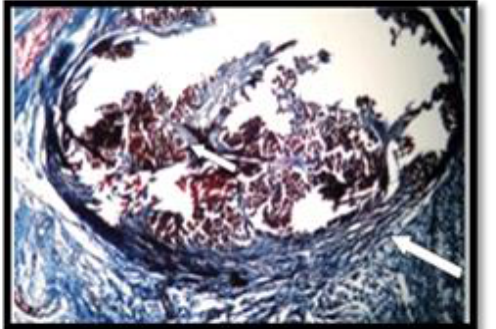
Figure, 9: BP-treatment group at 16th week post implantation, shows BP implant and surrounded (encapsulate) by thin zone of mature fibrous connective tissue(long arrow) with calcium percipitation (short arrow) and accompined with moderate vascular response (Mallory stain, 200X).